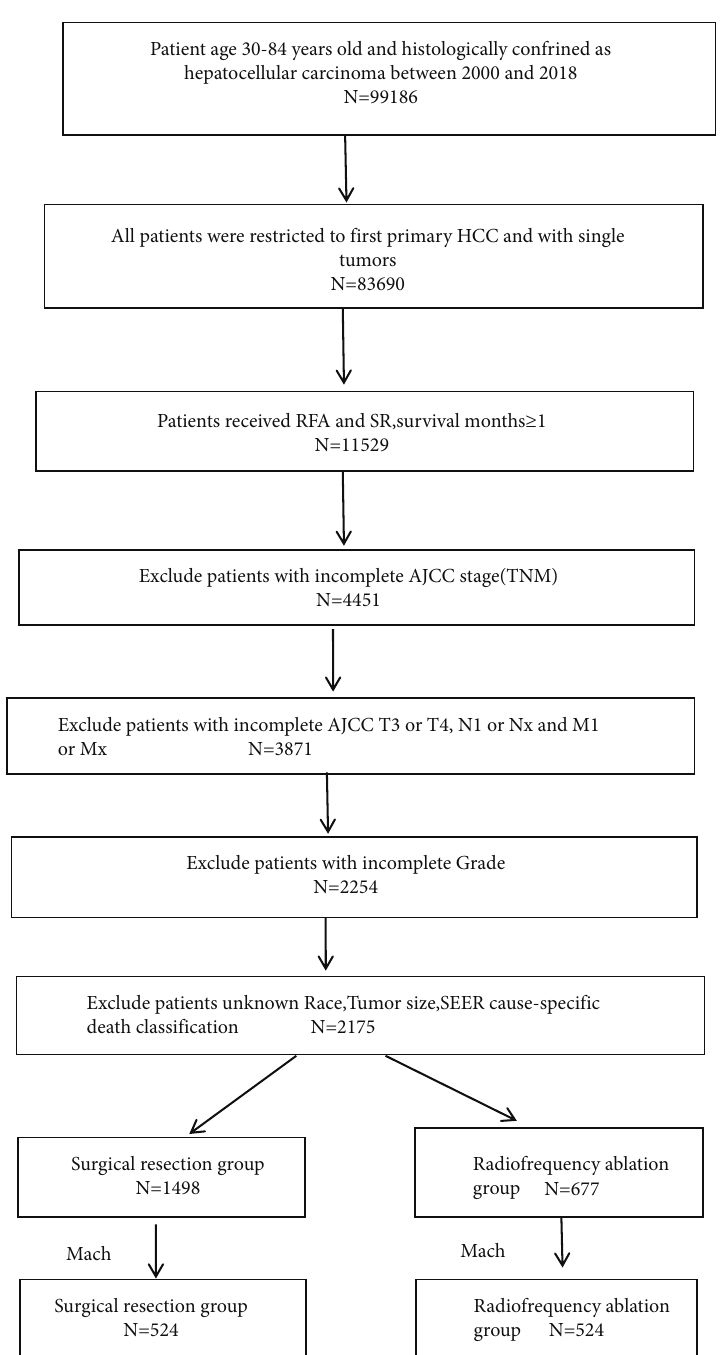
Figure 1: Flowchart of patient selection. HCC: hepatocellular carcinoma; RFA: radiofrequency ablation; SR: surgical resection. AJCC: American Joint Committee on Cancer (7th); SEER: the surveillance, epidemiology, and end